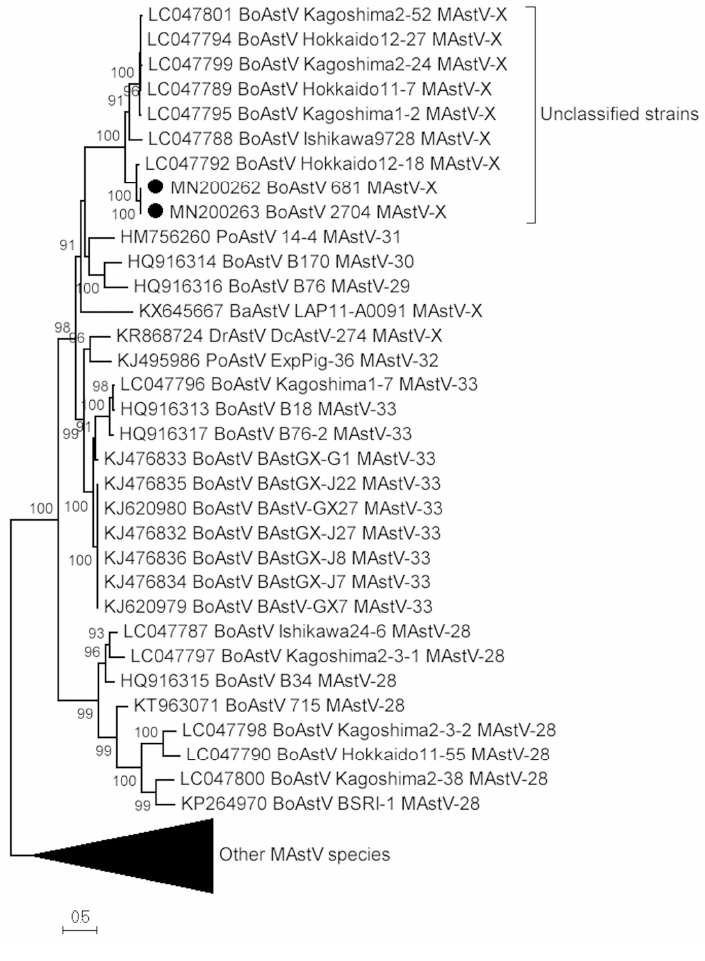
Figure 2. Maximum-likelihood tree constructed with complete capsid amino acid sequences. LG (General matrix) + gamma (with four categories of rates to approximate the gamma distribution) + invariant sites (allows a proportion of invariable sites) was used as the amino acid substitution model that best fit the data. All the assigned and tentatively assigned species of MAstV were included in the analysis (see Table S2); some were condensed for better visualization. The two Uruguayan strains are indicated with black-filled circles. The clade with the unclassified strains is shown. aLRT values higher than 90 are shown.